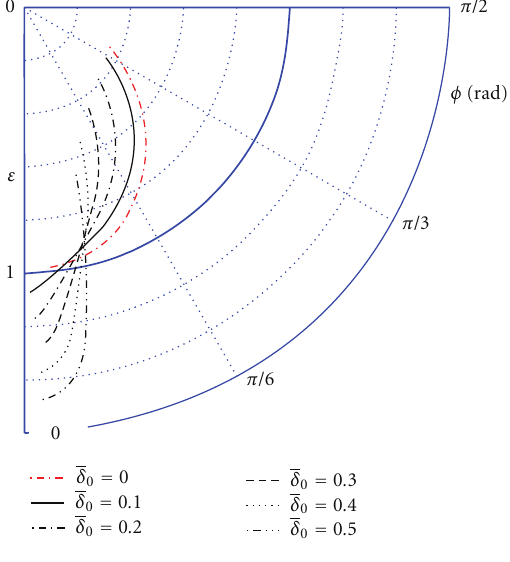
Figure 2: Loci of journal